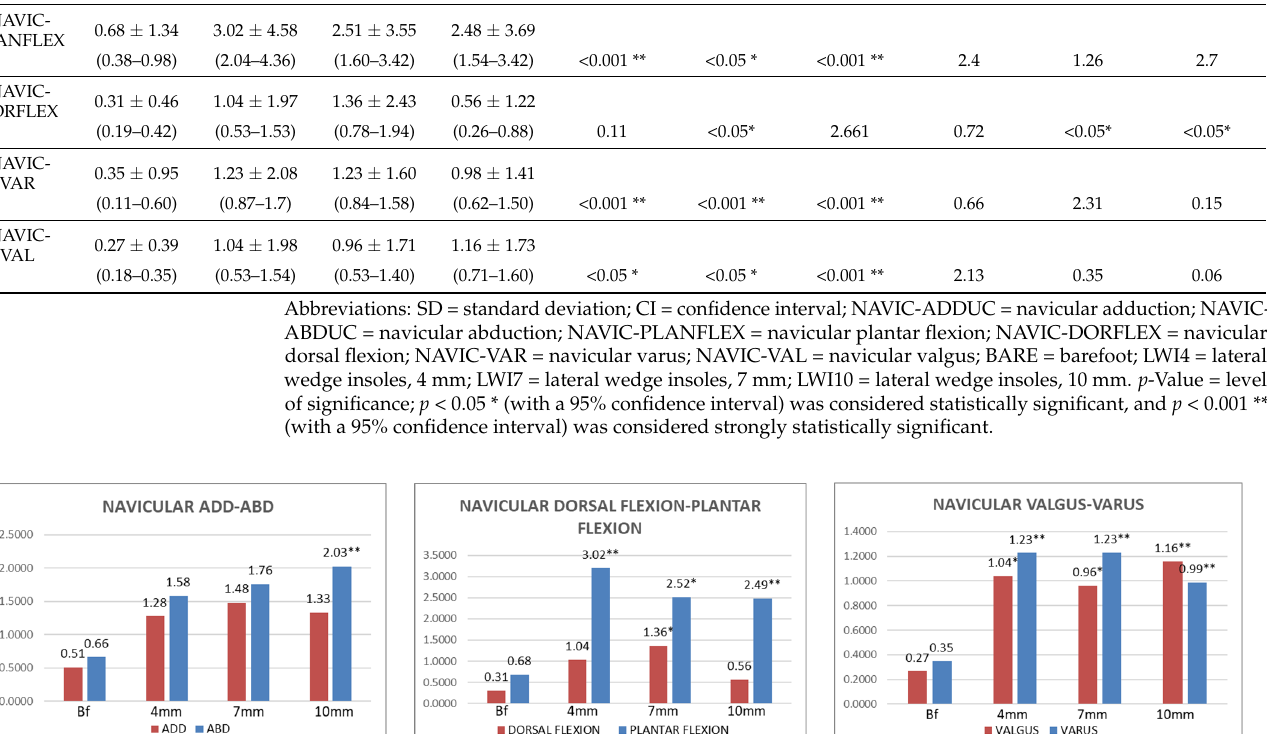
Table 5. The data of the navicular bone sensor movement under the four conditions.